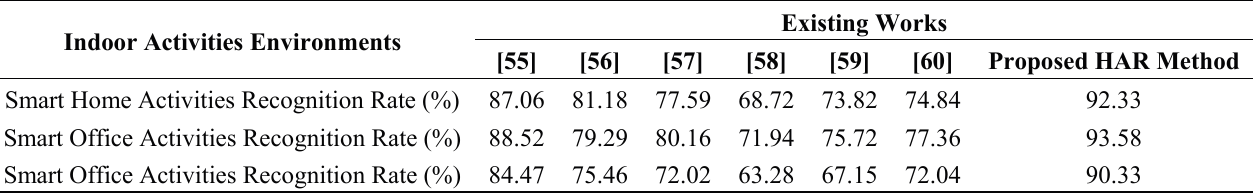
Table 12. Comparison results of the proposed HAR system with some of the existing works for all three smart indoor activities environments using six daily activities each, under the same setting conditions described in Section